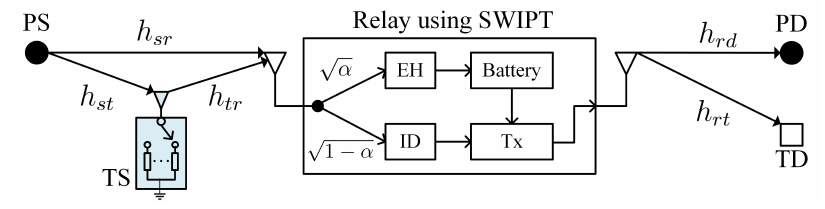
Figure 1. System model.